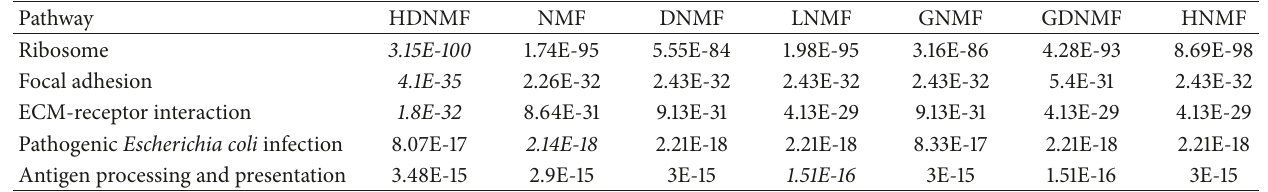
Table 12: The FDR of different methods (INTA